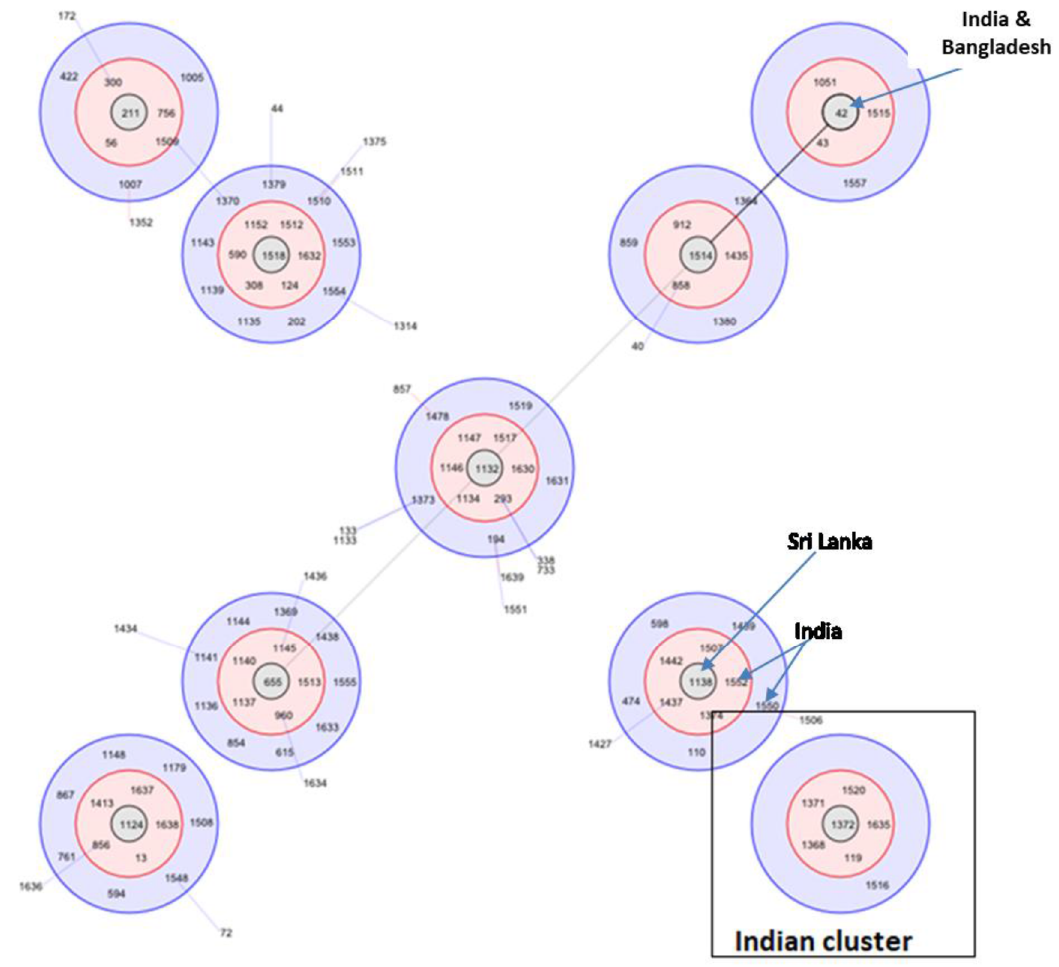
Figure 4. BURST cluster for South Asian countries with red shades depicting single locus variants and blue shades depict double locus variants linking the various STs. A group of Indian STs form a separate cluster not linked to other STs reported from other South Asian countries.